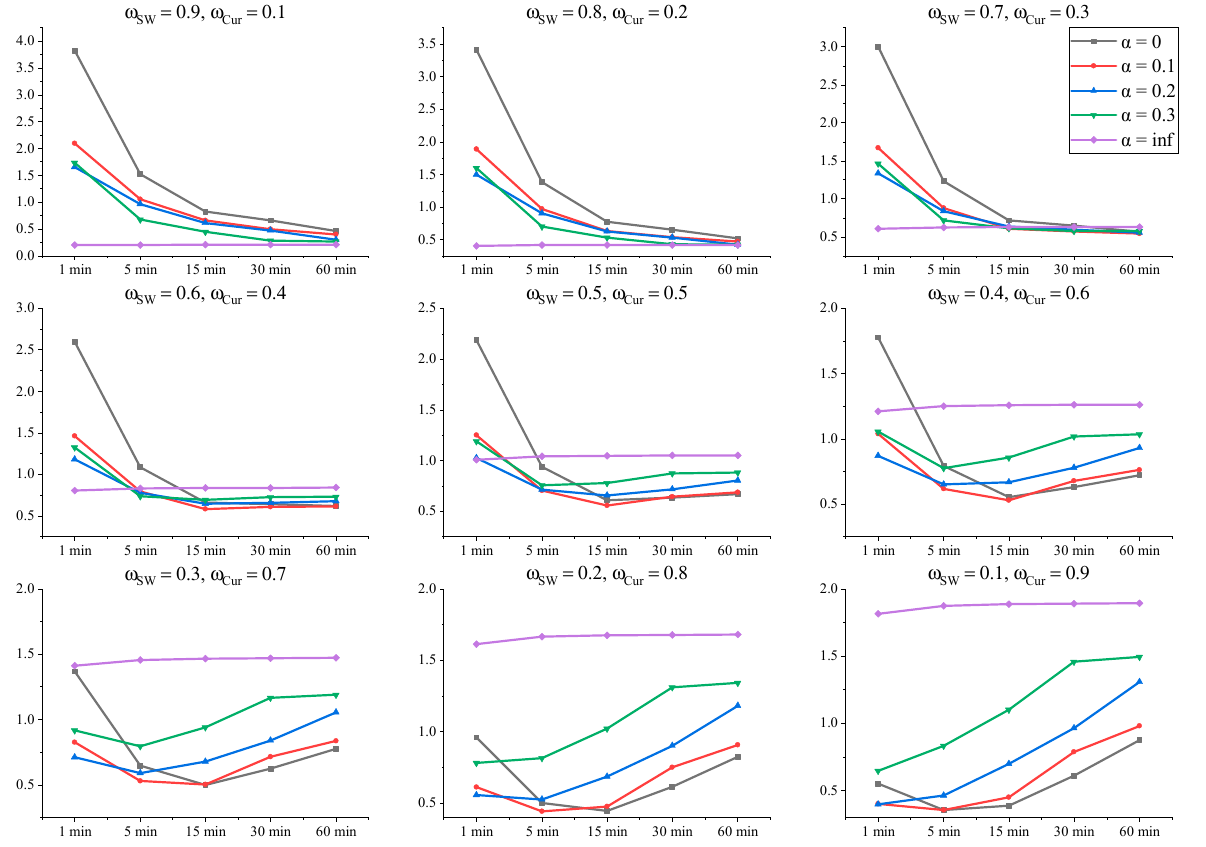
Figure 20. Comparison of P.I. for each case with respect to ω SW and ω Cur . When 𝜔 (cid:3004)(cid:3048)(cid:3045) ≥ 0.7, the P.I. value decreases with an increase in α value and a decrease